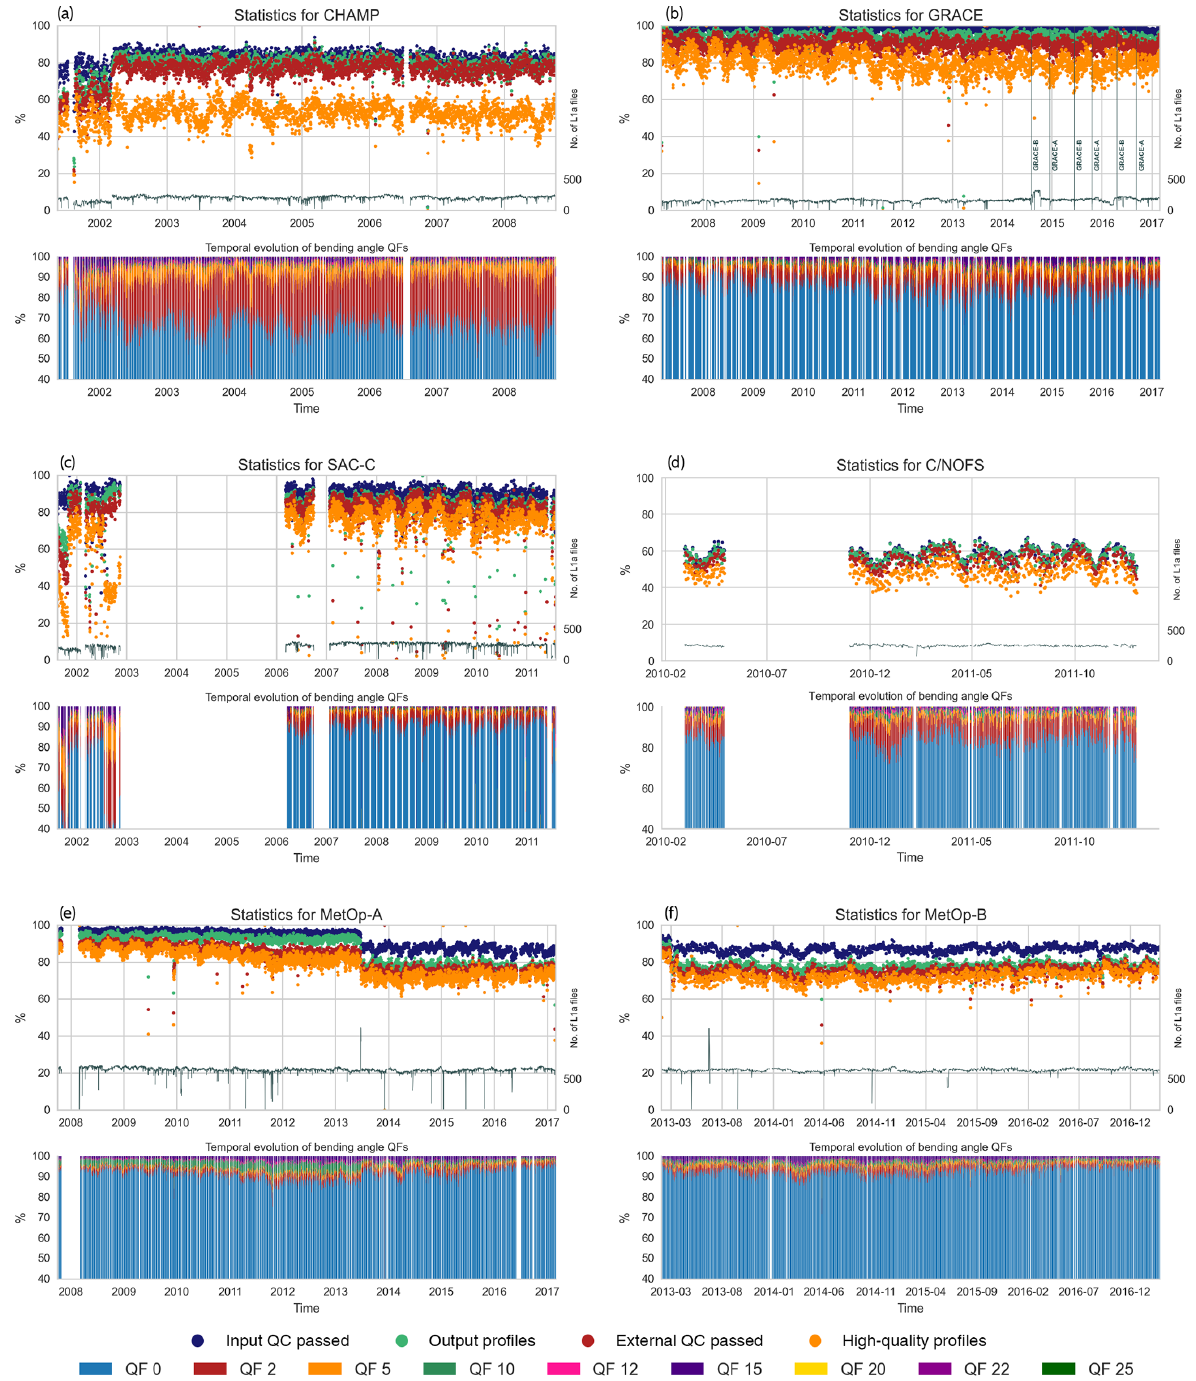
Figure 2. Temporal evolution of daily percentage of profiles (relative to total number of input data) passing the various QC steps for (a) CHAMP, (b) GRACE, (c) SAC-C, (d) C/NOFS, (e) MetOp-A and (f) MetOp-B (upper panels). Upper subpanels of (a) – (f) show the number of profiles passing the input QC (blue dots); the number of bending angle profiles passing internal QC, which equals the number of output profiles (green dots); the number of profiles that are within the defined limits in the external QC (bending angle QF is 0, 2, or 5, and all atmospheric QF are 0) (red dots); and the daily percentage of high-quality OPSv5.6 profiles (orange dots). Daily percentage of flagged profiles relative to the number of OPSv5.6 output profiles is shown separately for each bending angle QF in the lower